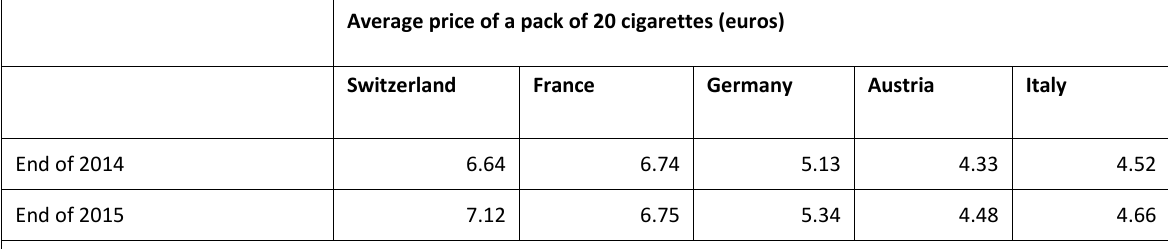
Table 4: Weighted average price for a pack of 20 cigarettes in Switzerland and neighbouring countries at end of 2014 and